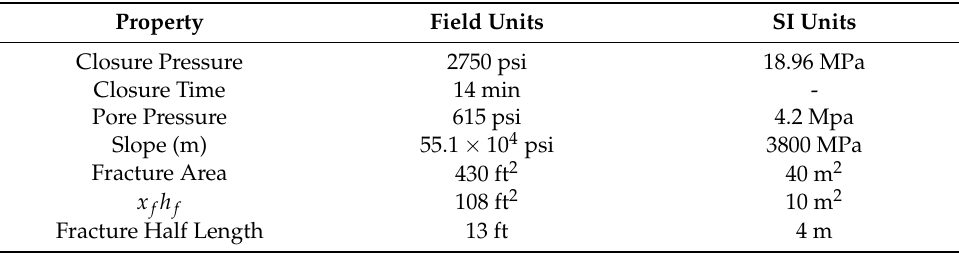
Table A1. Summary of analysis results of cycle